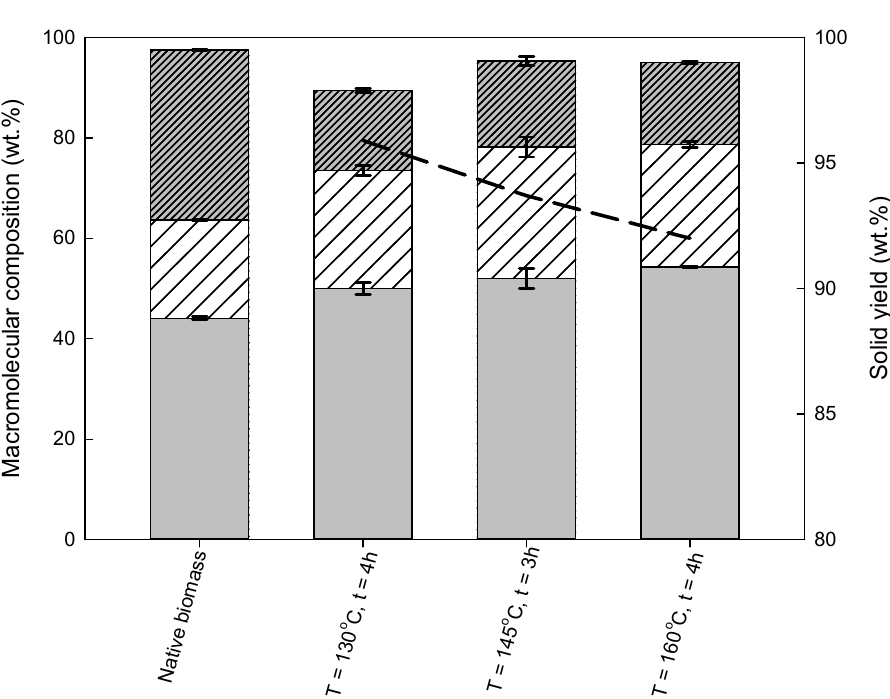
Figure 3. Native eucalyptus residues and solid fraction compositions (wt %), obtained from pre- treatment with imidazole at varied reaction temperatures and times. The black line represents the recovered solids (wt %). The cellulose amount depicted as the grey bar was measured as the glucan content. The hemicellulose amount represented as the white bar with a pattern was measured as the sum of xylan and arabinosyl group contents. Lignin content is depicted as the grey bar with a pattern. The contents of ash and other minor components are not shown for the clarity of the figure.